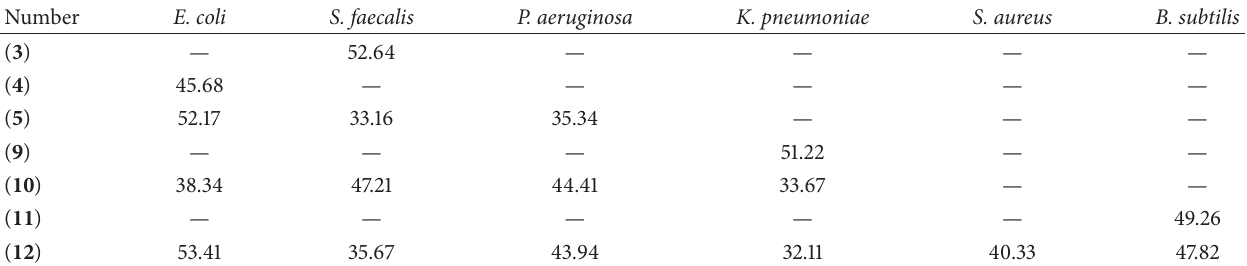
Table 3: Minimum inhibitory concentration ( 𝜇 g/mL) of the selected compounds ( 3 ) – ( 5 ) and ( 9 ) – ( 12 ) against selected